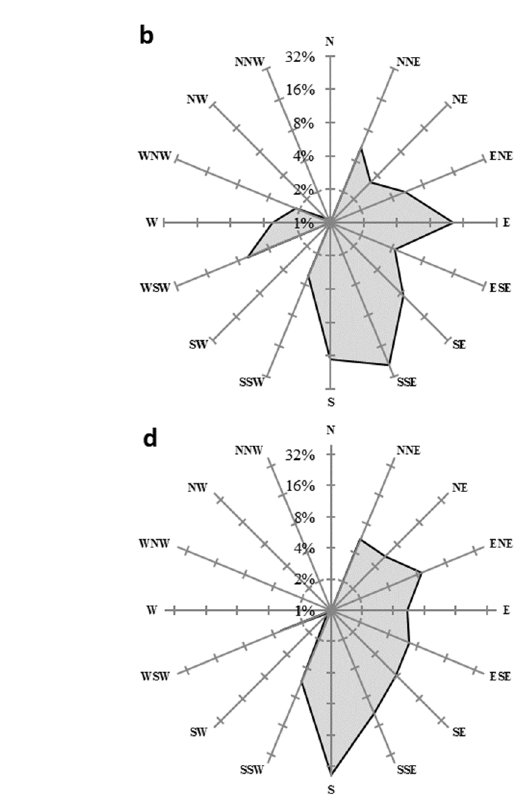
Figure 2. Wind rose plots (a) spring, (b) summer, (c) fall, and (d) winter for the study